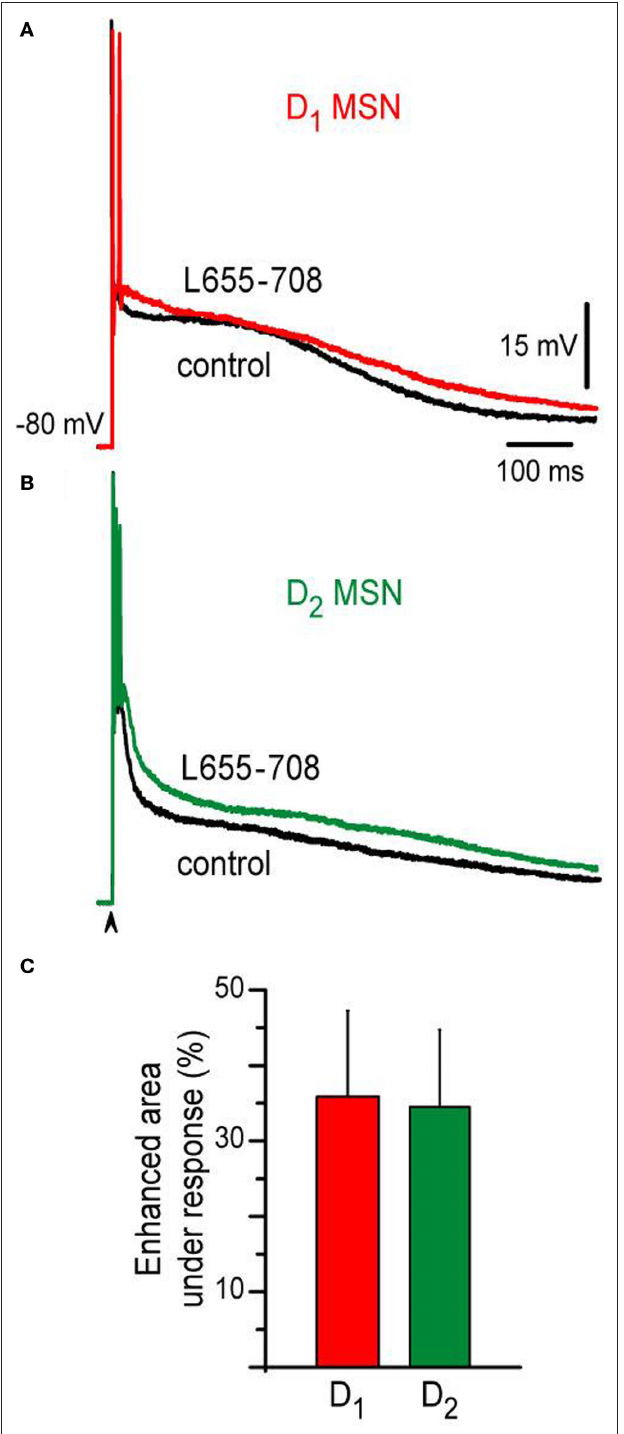
FiGure 4 | Action of an inverse selective agonist of GABA receptors A containing the α subunit on D - and D -MSNs corticostriatal responses. 5 1 2 (A) Superimposed corticostriatal responses from a D -MSN in control (black) 1 and during 10 μM L655-708 (red). (B) Superimposed corticostriatal responses from a D -MSN in control (black) and during 10 μM L655-708 (green). (C) 2 Histogram shows that L655-708 affected both responses similarly ( n =